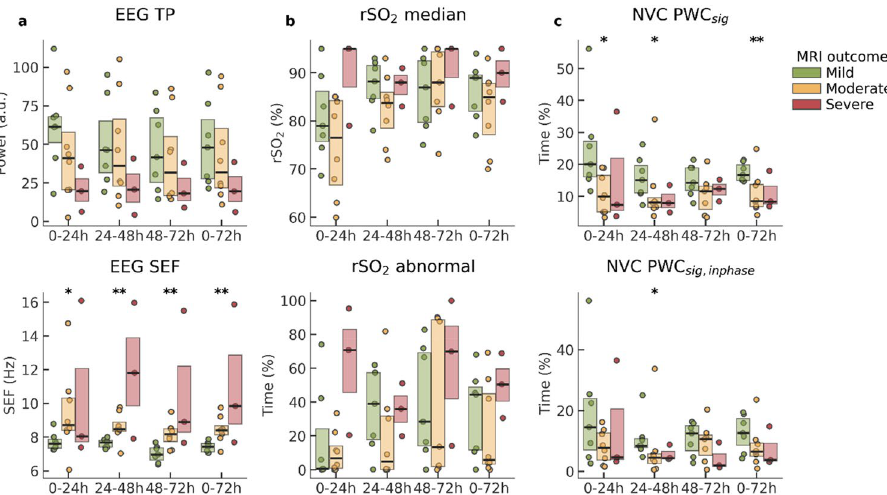
Figure 4. Biomarkers per outcome group per analysing window. ( a ) EEG biomarkers, ( b ) NIRS biomarkers, ( c ) NVC biomarkers. Hours are relative to the start of hypothermia. Asterisks indicate a significant difference (* p < 0.05, ** p < 0.01) between the mild vs the pooled moderate and severe group, using a Mann–Whitney U test. EEG TP: EEG total power (0.5–19.5 Hz), EEG SEF: EEG spectral edge frequency, rSO2 median: median rSO2 value, rSO2 abnormal: percentage of time where rSO2 is outside the normal range (55–90%), NVC PWC sig : percentage of time with significant coherence (all phases) in 0.25–1 mHz, NVC PWC sig,inphase : percentage of time with significant in-phase ( | φ | < 90 o ) coherence in 0.25–1 mHz.